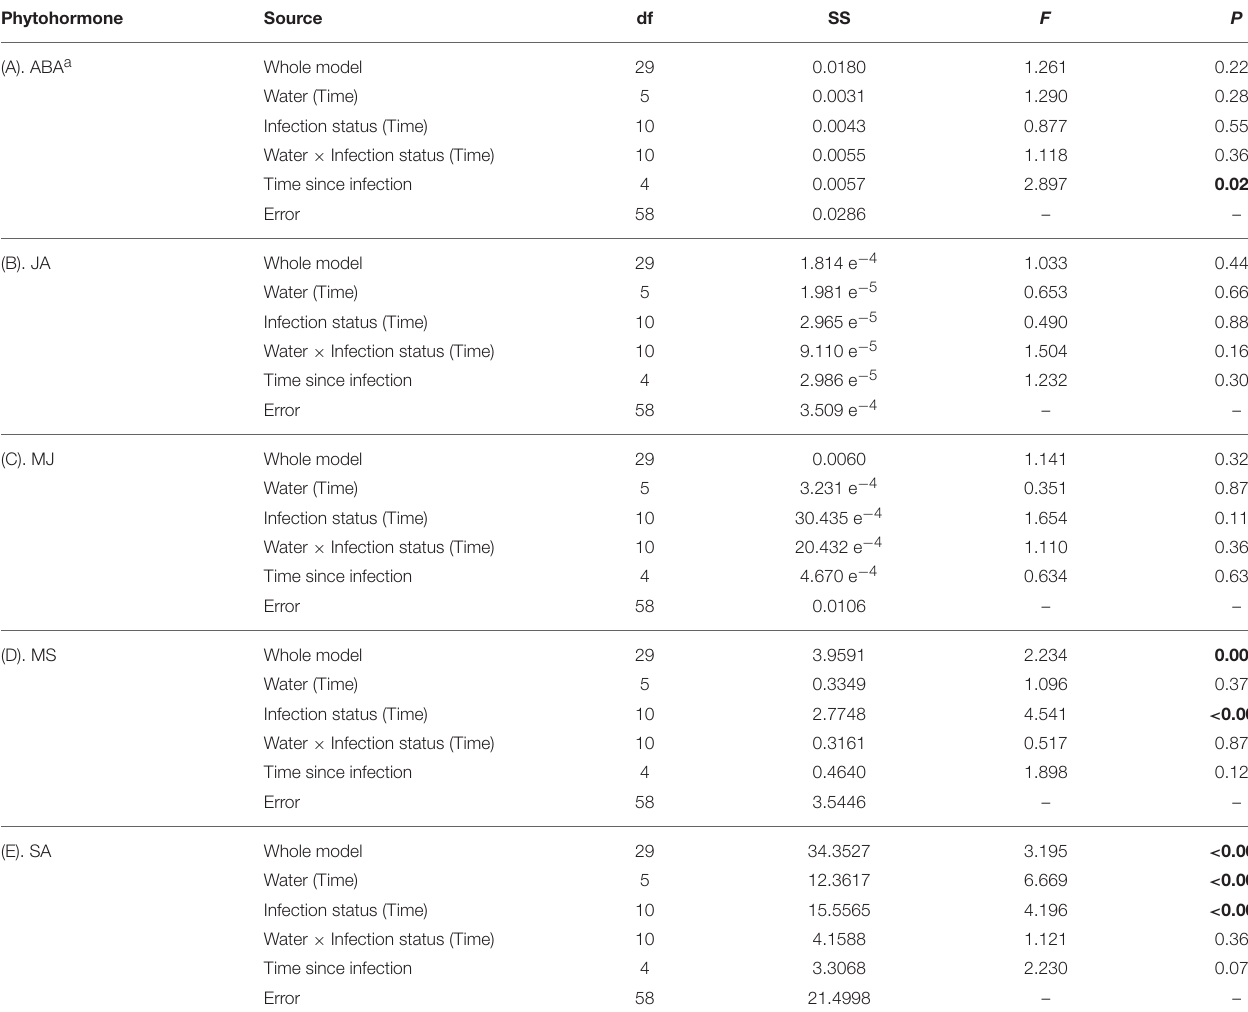
TABLE 1 | Summary of ANOVA model for the effects of water availability and virus infection treatment, nested by time since infection, on concentrations (mg/g) of five phytohormones in wheat leaf tissues. Phytohormone Source